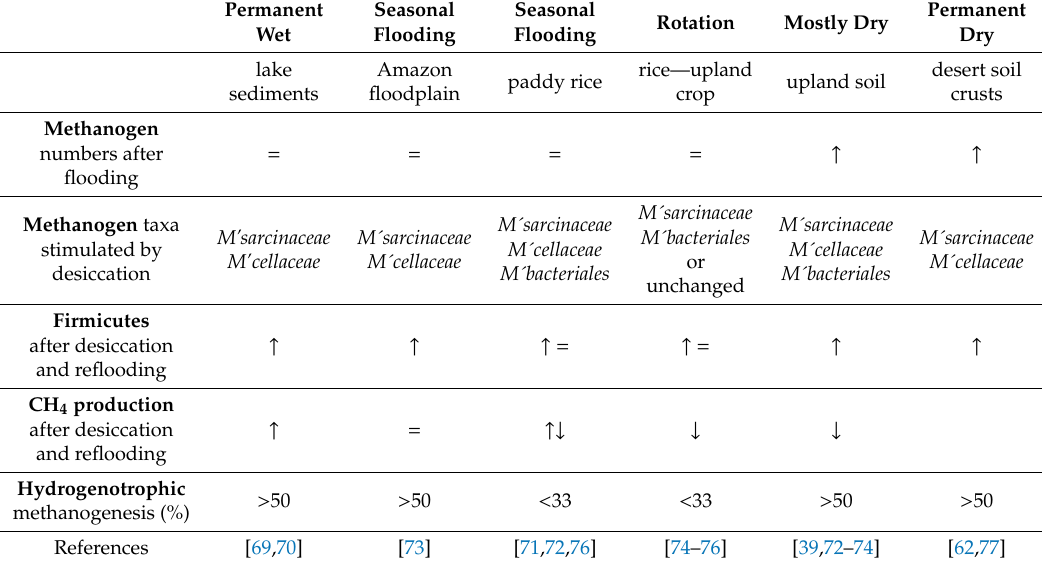
Table 1. E ff ects of desiccation or flooding on microbial populations and methanogenic functions in soils across a gradient from permanent wet to permanent dry conditions. (The symbols denote the following: = constant; ↑ increase; ↓